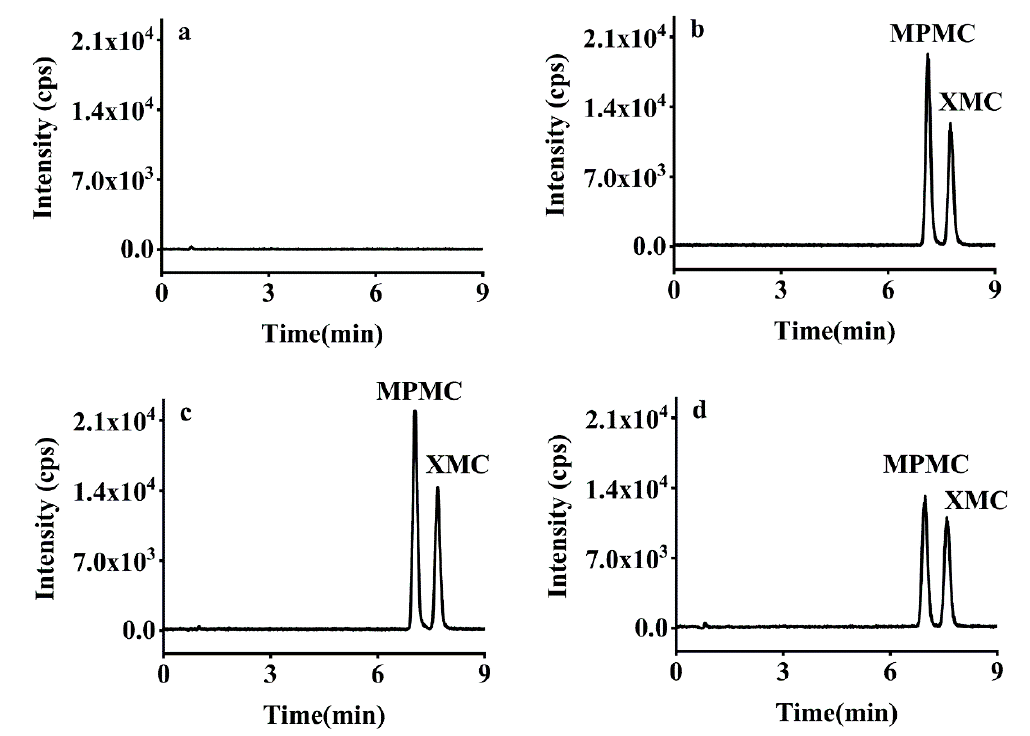
Figure 4. Typical HPLC-MS/MS chromatograms of dimethacarb in ( a ) blank brown rice ( b ) solvent standard solution (0.005 µ g/mL), ( c ) matrix-matched standard solution (0.005 µ g/mL), and ( d ) spiked brown rice (0.01 mg/kg).